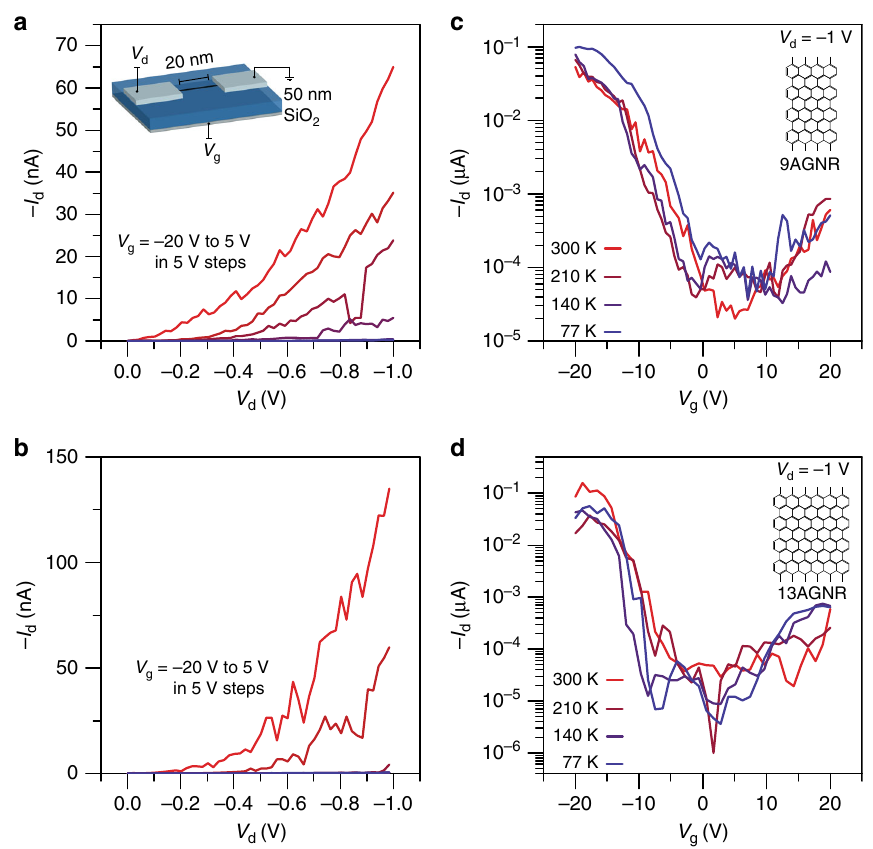
Fig. 3 Transport characteristics of 9AGNRs and 13AGNRs gated with 50 nm SiO 2 gate oxide. The presence of a SB is con fi rmed by non-linear current behavior at low drain bias and lack of current saturation at high drain bias for both a 9AGNRs and b 13AGNRs. The weak temperature dependence in the I − V d g behavior in c 9AGNRs and d 13AGNRs indicates that tunneling through the Pd-GNR SBs is the limiting transport mechanism of the device